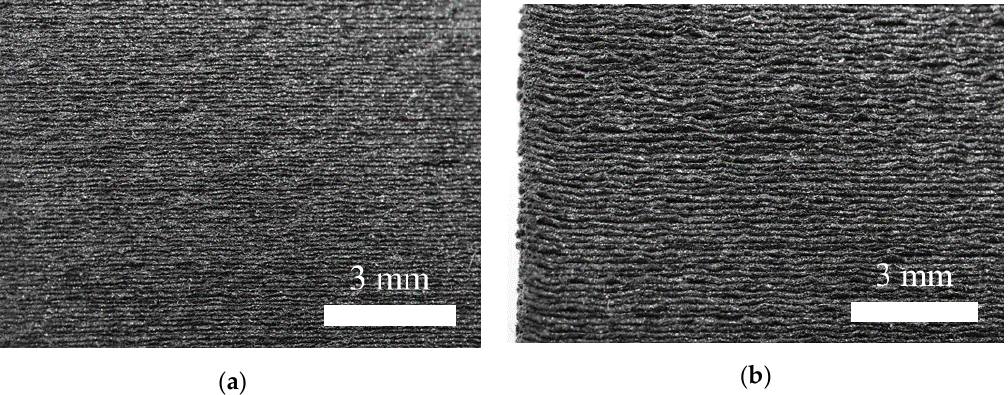
Figure 7. Macroscopic visualization of the manufacturing quality. ( a ) LH 0.2; ( b ) LH 0.3.